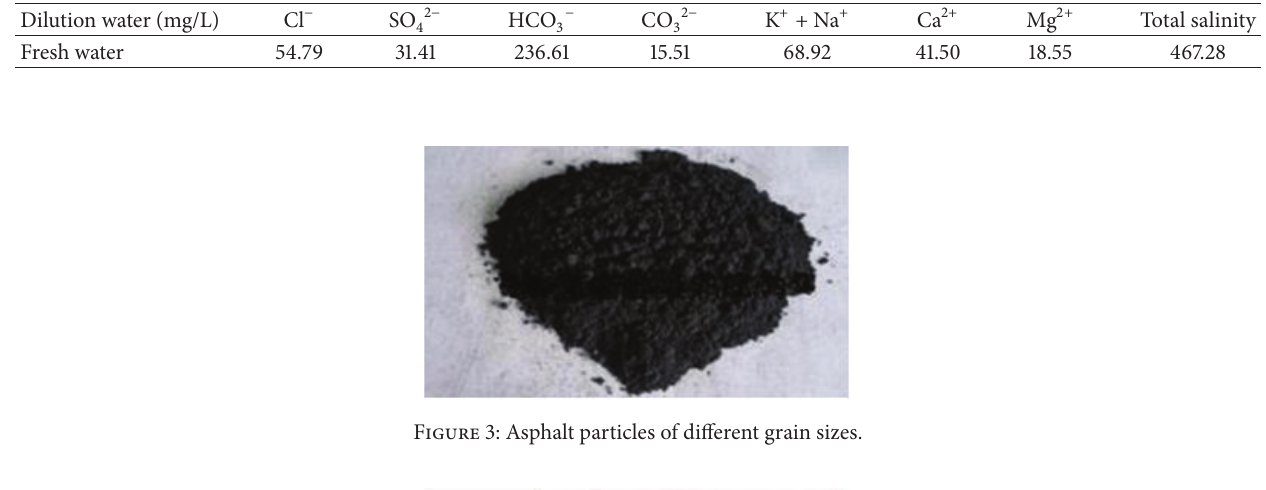
Table 1: Water salinity composition.